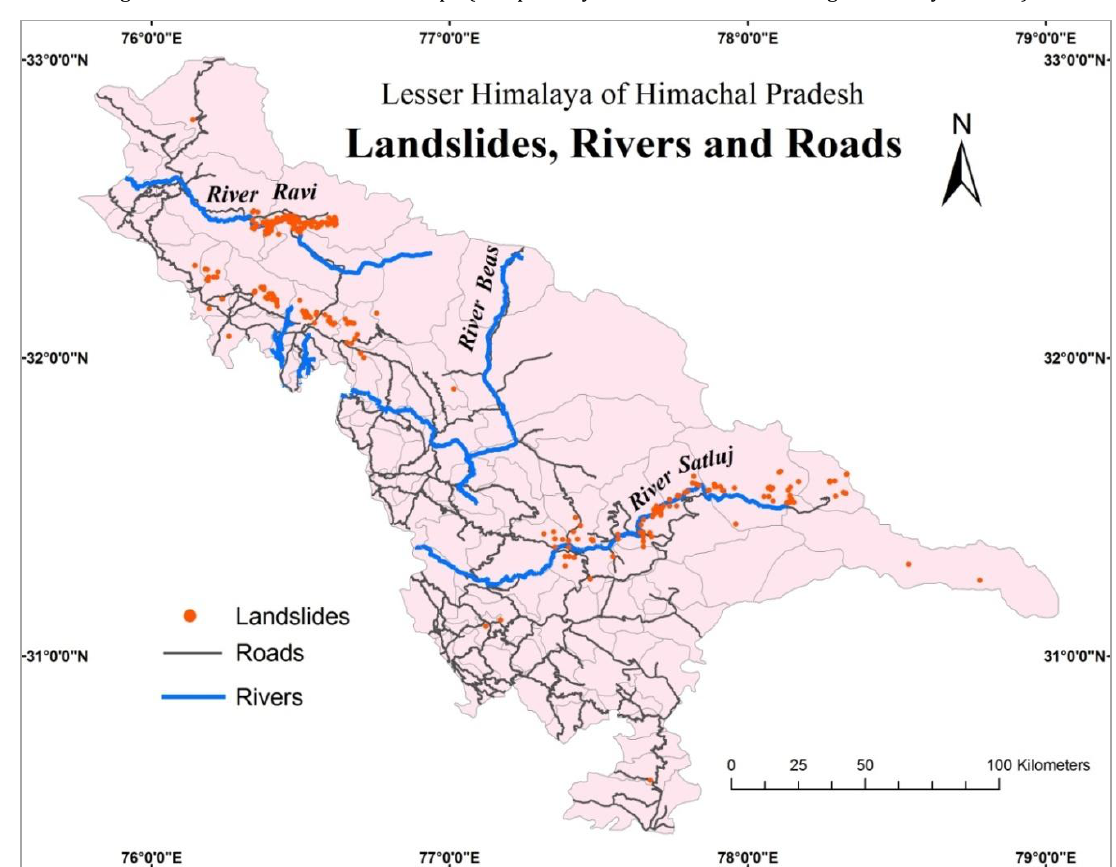
Fig. 4. Landslides, structure and slope (compiled by Authors based on Geological Survey of India)